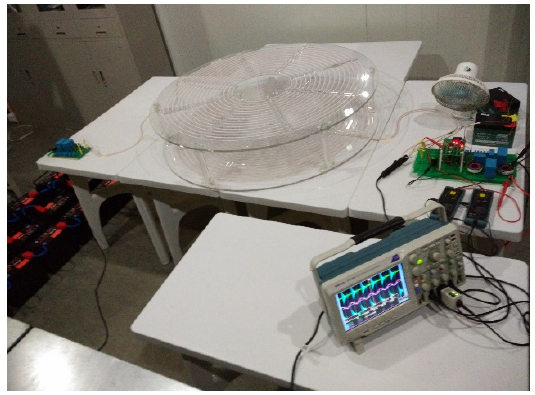
Figure 19. A prototype of a wireless charging